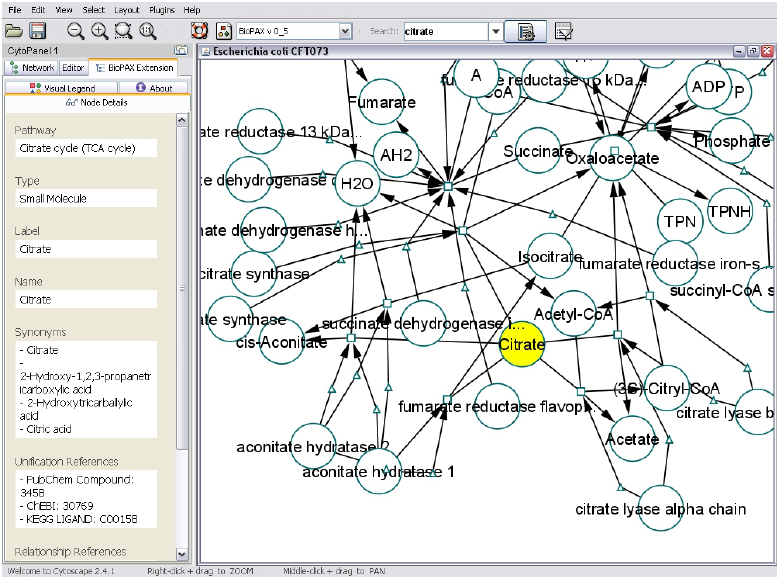
Figure 7: A visualisation of the TCA cycle of Escherichia coli in Cytoscape